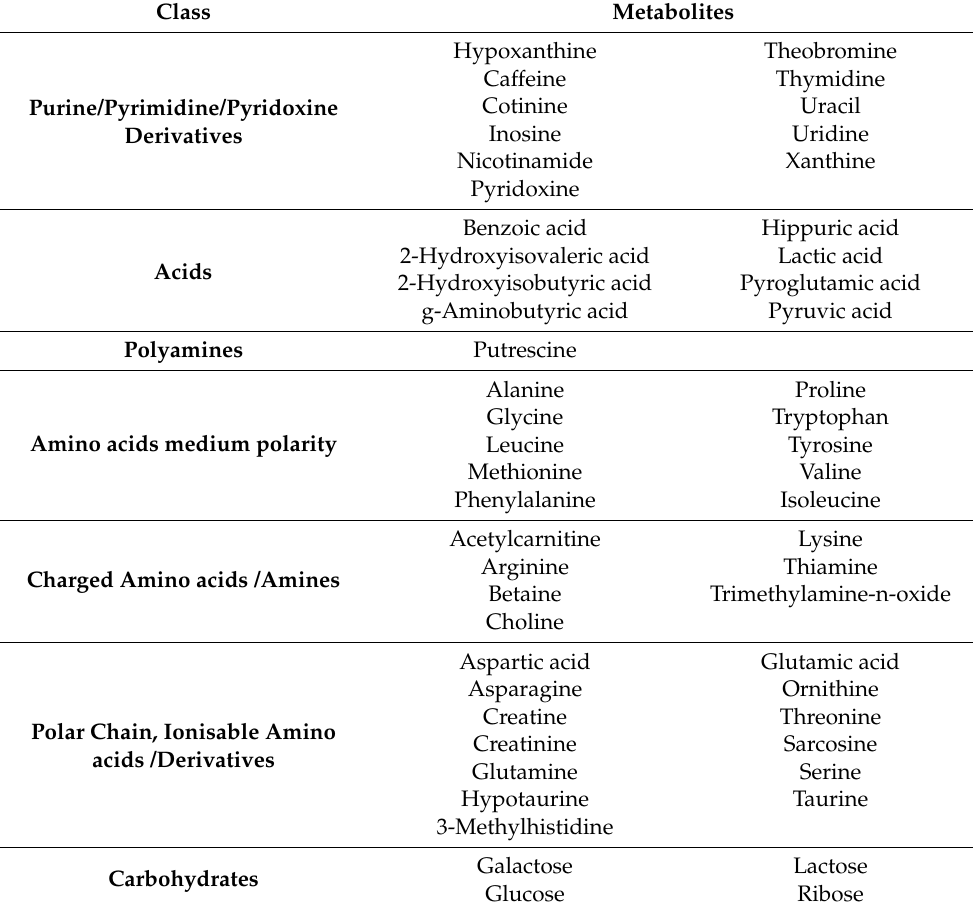
Table 1. Target metabolites per class of compounds determined in serum by the applied analytical